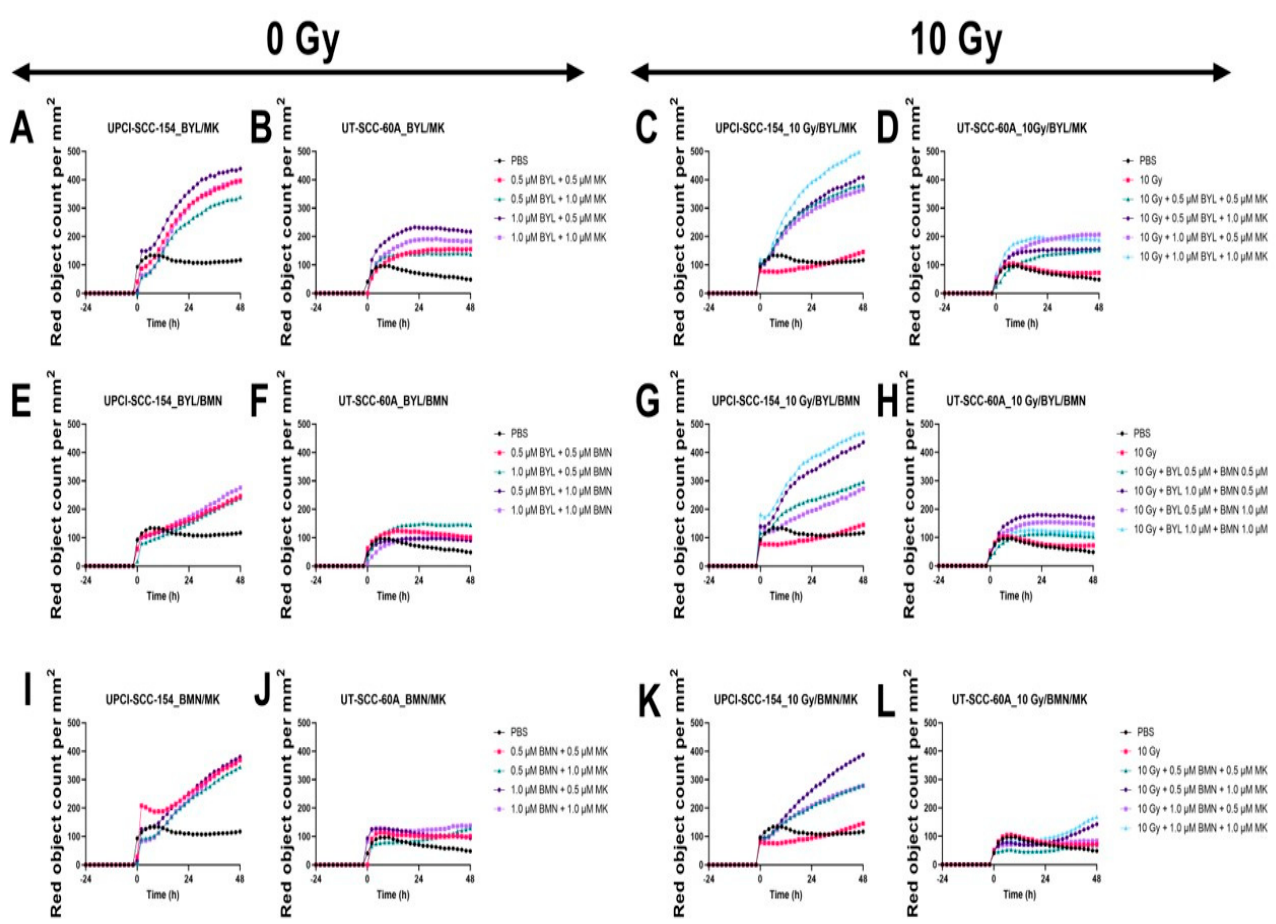
Figure 9. Cytotoxicity response of the HPV+ UPCI-SCC-154 and HPV − UT-SCC-60A cell lines upon treatment with MK-1775/BYL719 with/without (w/wo) 10 Gy ( A – D ), BYL719/BMN-673 w/wo 10 Gy ( E – H ), or MK-1775/BMN-673 w/wo 10 Gy ( I – L ). The graphs represent one experimental run per cell line. BYL denotes BYL719, BMN denotes BMN-673, and MK denotes MK-1775.